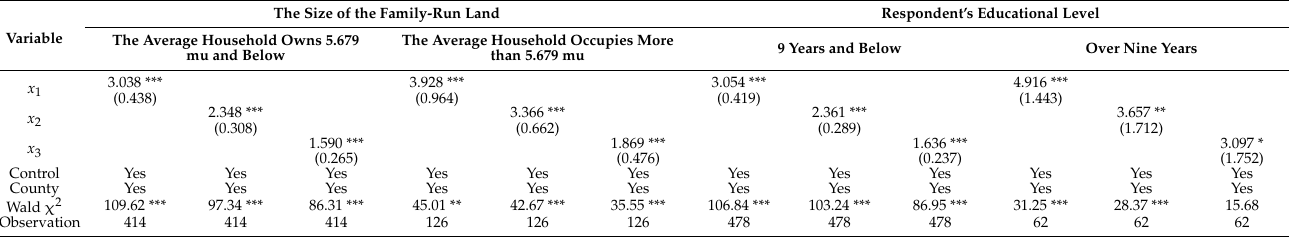
Table 5. Heterogeneity